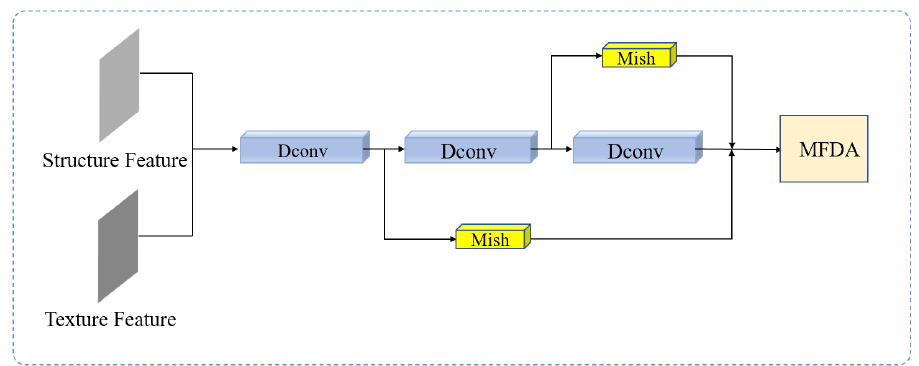
Figure 5. Mapping network structure